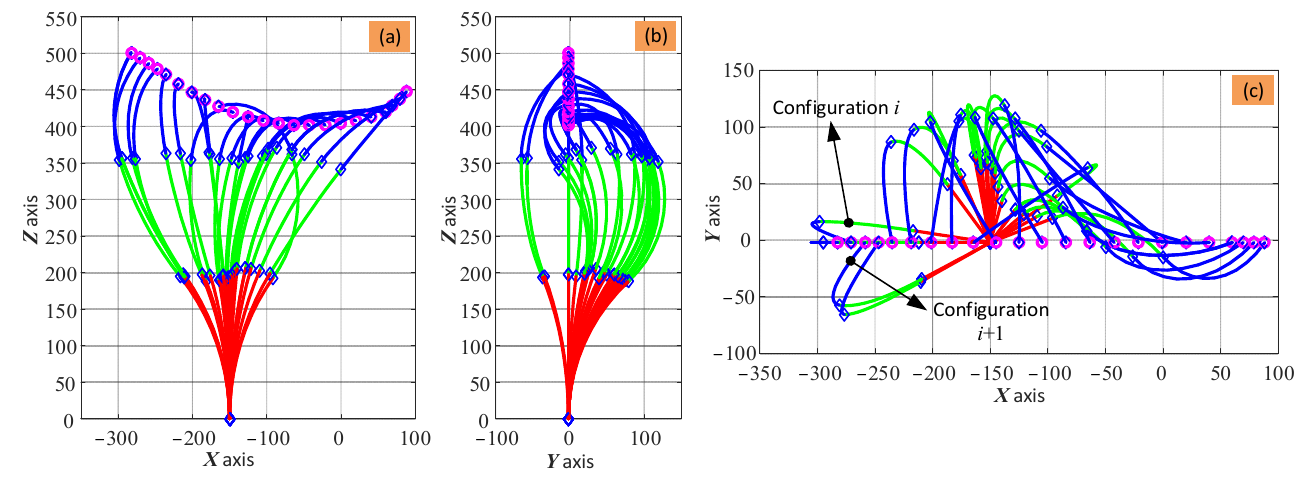
Figure 8. Results of the optimization-based algorithm for the inverse kinematic calculation of the 6-DoF continuum arm at each point along the toolpath: ( a – c ) are the front view, side view, and top view of the arm, respectively. Note: there are no constraints for the phase angle ( ϕ i , i = 1,2,3) of the three sections, and the actuation system is omitted for clarity.